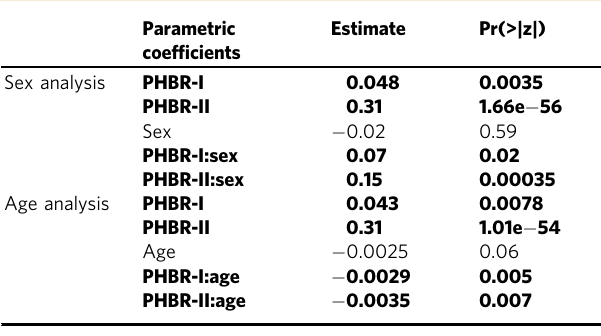
Table 1 Quantitative estimate of the association between PHBR score and mutation occurrence in sex- and age- speci fi c